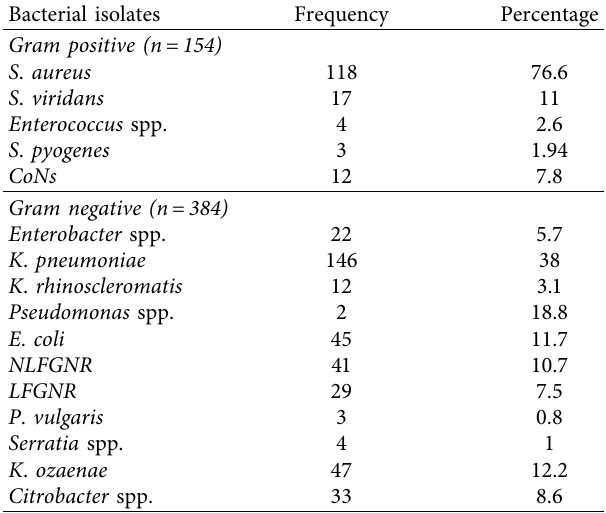
Table 1: Frequency of study participants by age groups, gender, year, and wards at University of Gondar Comprehensive Spe- cialized Hospital, Gondar, Northwest Ethiopia, 2021.